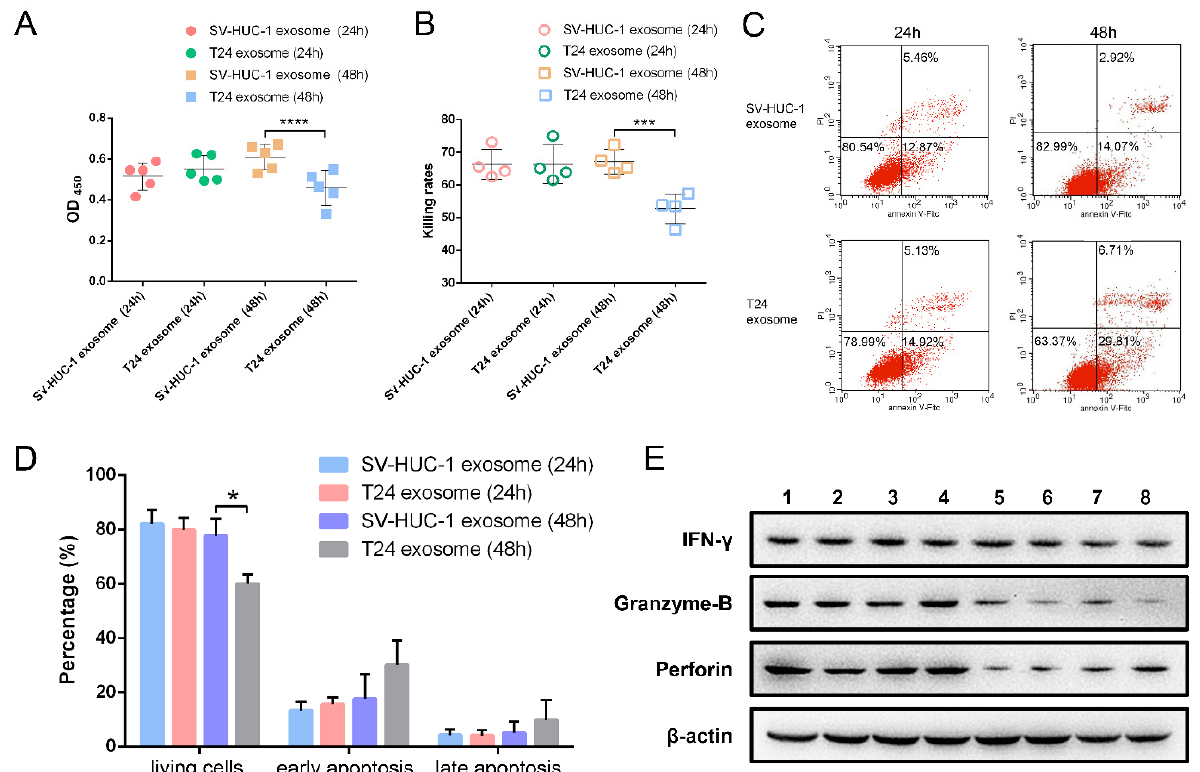
Figure 4. The effects of T24 exosome on NK cells viability, cytotoxicity, apoptosis, and cytokines expression. ( A ): The viability of NK cells after 24 h and 48 h T24 exosome treatment (n = 5). **** t test, p < 0.0001; *** t test, p < 0.001. ( B ): The killing rate of NK cells after 24 h and 48 h T24 exosome treatment (n = 4). ( C ): The representative flow cytometry data of NK cell apoptosis. ( D ): The bar graph showed the percentage of viable (Annexin V − /PI − ), early apoptotic (Annexin V + /PI − ), and late apoptotic/necrotic (Annexin V + /PI + ) cells in each group (n = 5). T24 exosome treatment significant decrease the proportion of living NK cells after 48h treatment. * t test, p < 0.05. ( E ). Western blot analysis of cytokines (IFN- γ , perforin, granzyme-B) secretion of NK cells. Line 1–4, treated by SV-HUC exosomes, line 5–8, treated by T24 exosomes. The expression of granzyme-B and perforin were decreased after T24 exosome treatment.